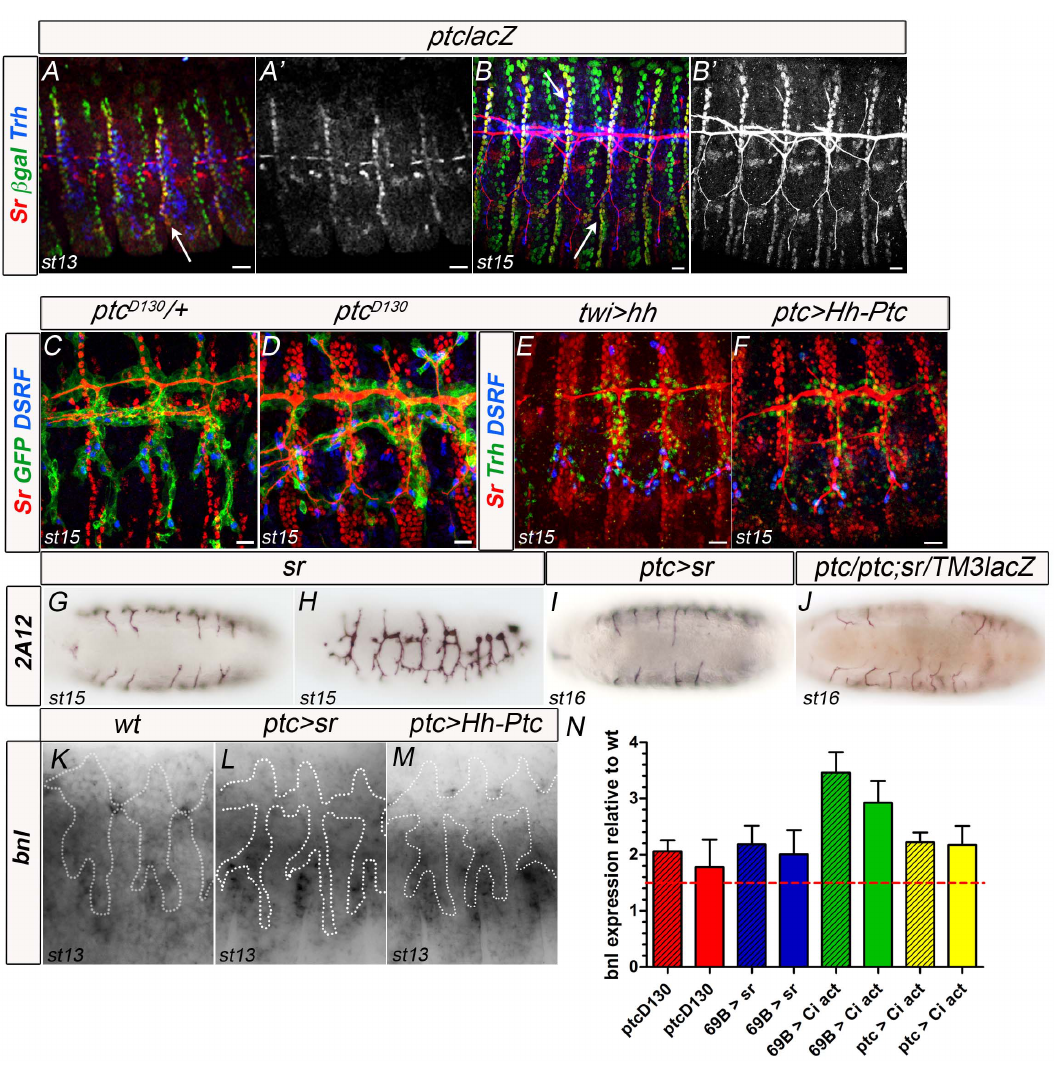
Figure 7. Hh signalling regulates bnl transcription through the induction of stripe ( sr ). (A, B) Stage 13 (A, A 9 ) and 15 (B, B 9 ) embryos carrying the ptclacZ reporter stained with anti- b gal, anti-SrB antibody and anti-Trh. Sr is expressed in some ptc -expressing cells, in particular cells surrounding the Ltp/GB (arrows). At late stages, anti-SrB antibody is unspecifically detected in the tracheal lumen. Scale bars are 10 m m. (C, D) Stage 15 ptc heterozygous (C) or homozygous (D) embryos stained with anti-SrB, anti-GFP and anti-DSRF. The Sr expression domain is enlarged in ptc mutant embryos. Scale bars are 10 m m. (E, F) Stage 15 embryos overexpressing hh in twi -expressing cells (E) and overexpressing Hh-Ptc in ptc expressing cells (F) stained with anti-SrB, anti-Trh and anti-DSRF. The Sr expression domain is enlarged in both overexpression experiments. Scale bars are 10 m m. (G, H) Ventral and lateral view of a stage 15 sr mutant embryo stained with 2A12 to visualise the tracheal lumen. (I) Ventral view of a stage 16 embryo overexpressing sr in ptc -expressing cells stained with 2A12 to visualise the tracheal lumen. (J) Ventral view of a stage 16 ptc mutant embryo heterozygous for sr stained with 2A12 to visualise the tracheal lumen in black and b gal to mark the TM3ftzlacZ balancer in brown; midline cells are marked in brown. (K, L, M) bnl expression in stage 13 wt embryos (G), embryos expressing Hh-Ptc (H) and expressing sr (I) in ptc -expressing cells. Marked area contains trh -expressing cells (from another channel, not shown). Anterior is left in all panels. (N) Graphic representation of quantitative Real-Time PCR results. The two columns with the same colour represent independent experiments using the same genotype. Hashed red line marks 1.5-fold expression. All overexpression experiments induce greater levels of bnl expression than those in wt. P-values # 0.01.